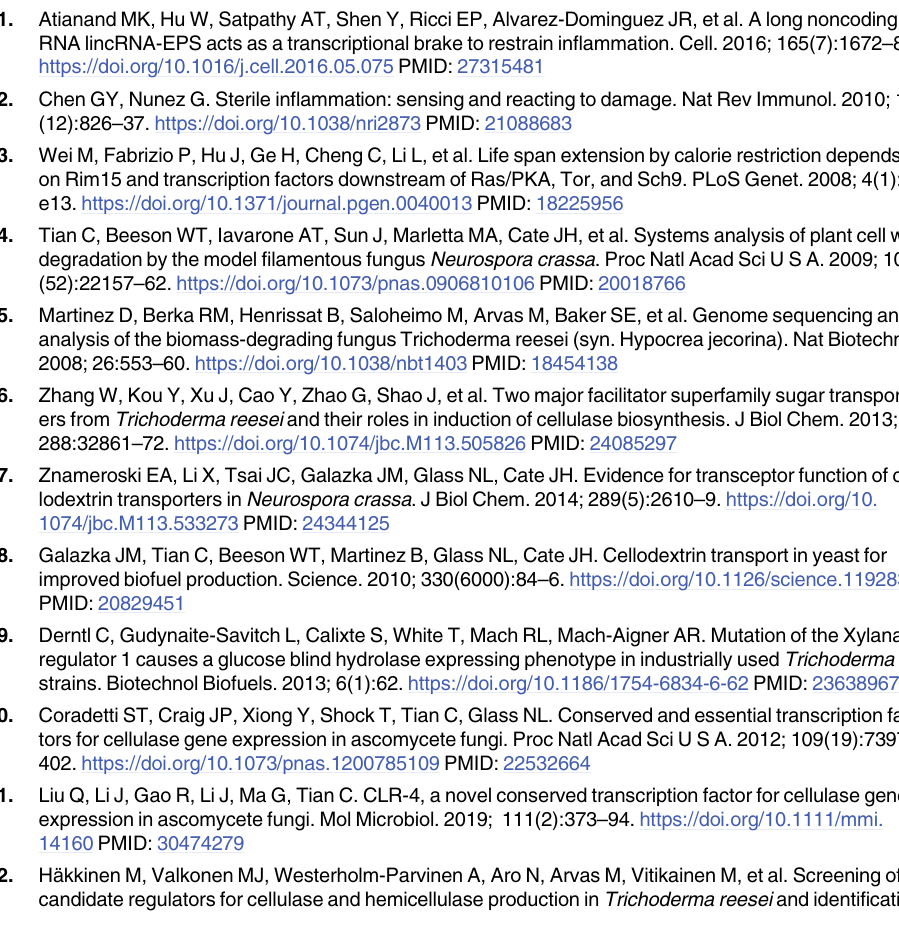
S5 Table. Primers used in this study.